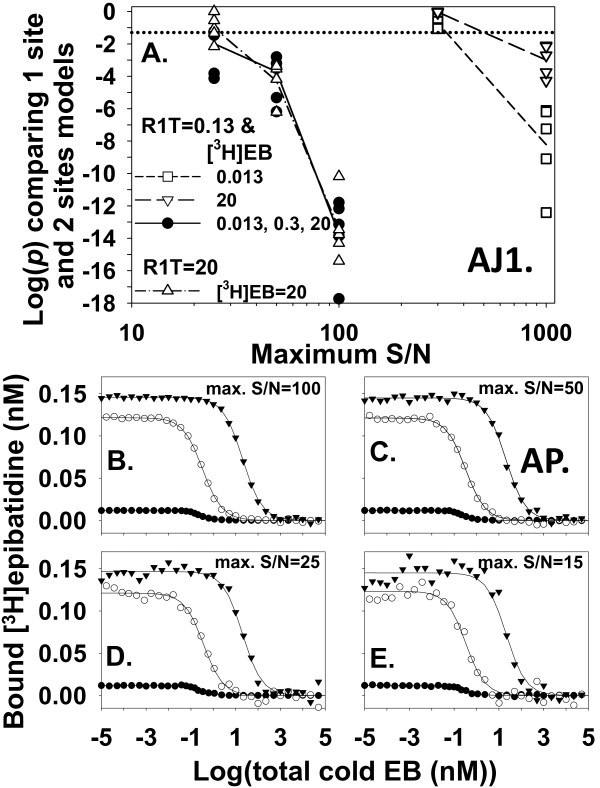
Data exploring a wide range of fractional occupancies of both binding sites help identify the low affinity binding site with homologous competition data with zero NSB. A. The p-values comparing one site modeltotal and two sites modeltotal depend on the maximum S/N in the homologous competition data. With R1T = 0.13 nM, single concentrations of [3H]EB with ([3H]EB = 0.013 nM; □; average log(p), short dashed line) or without ([3H]EB = 20 nM;∇; average log(p), long dashed line) ligand depletion require highly precise data (maximum S/N > 300) to consistently achieve p < 0.05 (p = 0.05, dotted line). When [3H]EB and R1T are 20 nM (Δ; average log(p), dash-dot line) and ligand depletion is significant, less precise data are needed to consistently achieve p < 0.05. With the same number of data points (114 points), simultaneous fitting of data from concentrations of [3H]EB at 0.013, 0.3, and 20 nM with R1T = 0.13 nM (●; average log(p), solid line) also needs less precise data to consistently achieve p < 0.05. Number of trials at each concentration and S/N value was 5. Estimates of dissociation constants and binding site concentrations are not significantly different from true values when S/N = 50. The CIs of Kd1 (9.6 - 13.8 pM; mean = 11.5 pM) and Kd2 (1.9-22.0 nM; mean = 6.5 nM) and CIs of R1T (0.126-0.131; mean = 0.128) and R2T (0.0198-0.0315; mean = 0.0256) (n = 5 for each CI) included the true values. B, C, D, and E. The two sites modelfree generated noisy homologous competition data sets with R1T = 0.13 nM; [3H]EB = 0.013 (●), 0.3 (○), and 20 nM (▼); and maximum S/N = 100 (B), 50 (C), 25 (D), and 15 (E). Fitting the one site modeltotal and two sites modeltotal to these types of data sets produced p values in A. Lines shown are fits of two sites modeltotal.